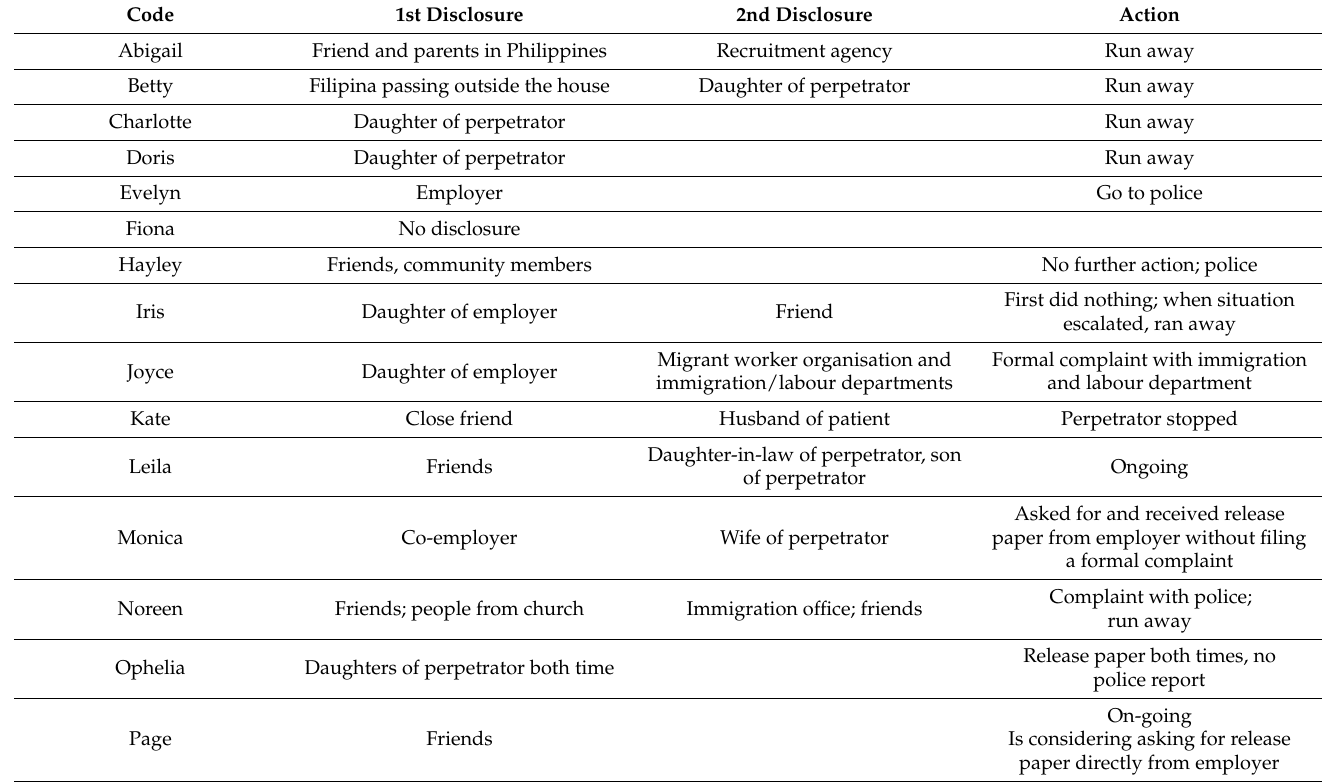
Table 3. Information on the action taken by victims to deal with the